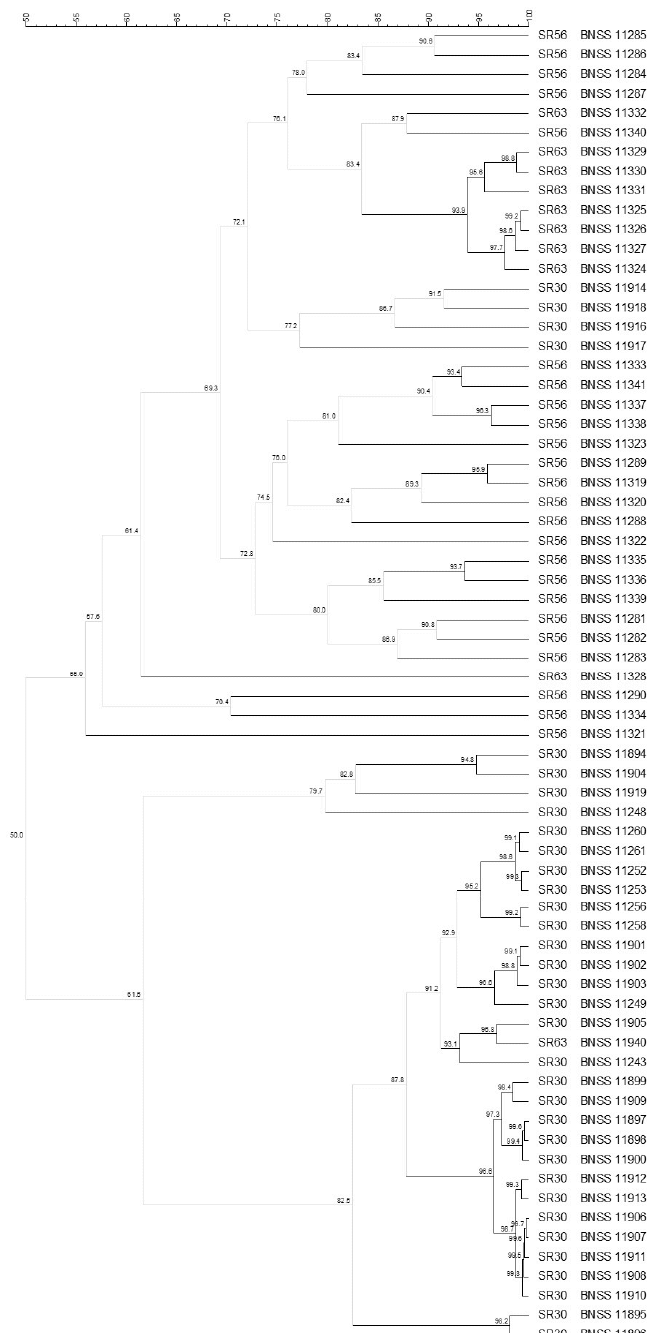
Figure 4. UPGMA cluster analysis, using Pearson correlation, of (GTG) 5 rep-PCR and PFGE elaborated by composite data set comparison tool, of 68 Enterococcus faecium isolates from SR30, SR56, and SR63 natural cultures. For each isolate, the indication of the culture (30, 56 or 63) and the BNSS ID were reported.